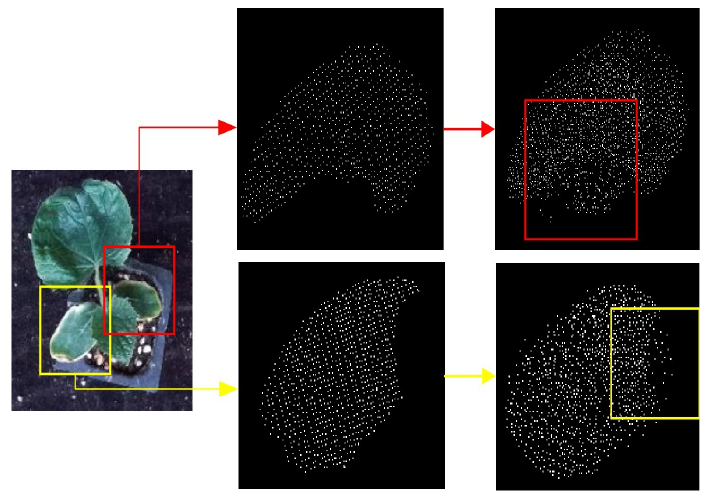
Figure 10. Complementary results of MIX-Net in real phenotypic measurements, where indicates the presence of occlusion in phenotypic measurements of seedlings and our corresponding complemen- tary results.